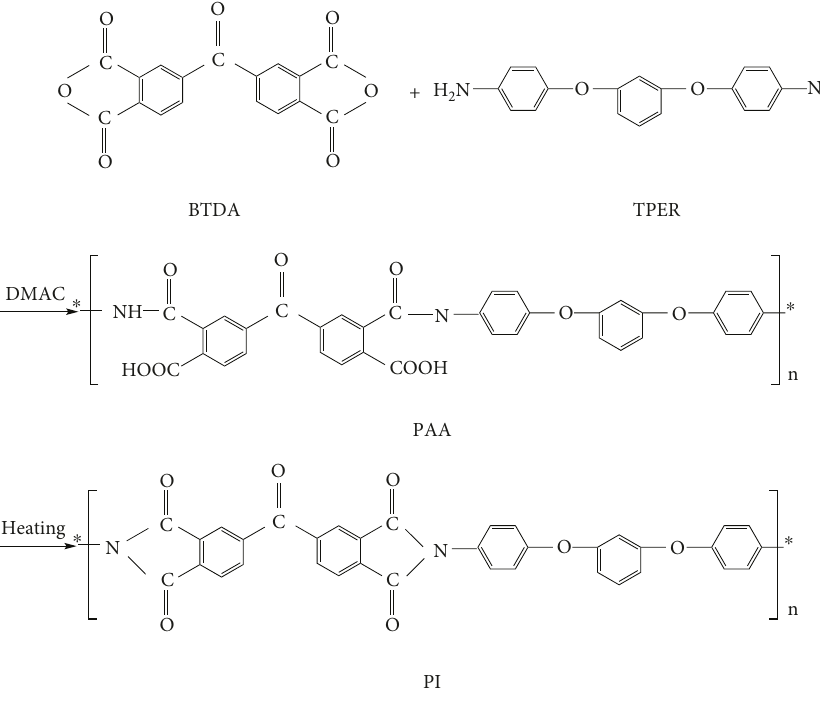
Scheme 1: Preparation of BTDA-TPER